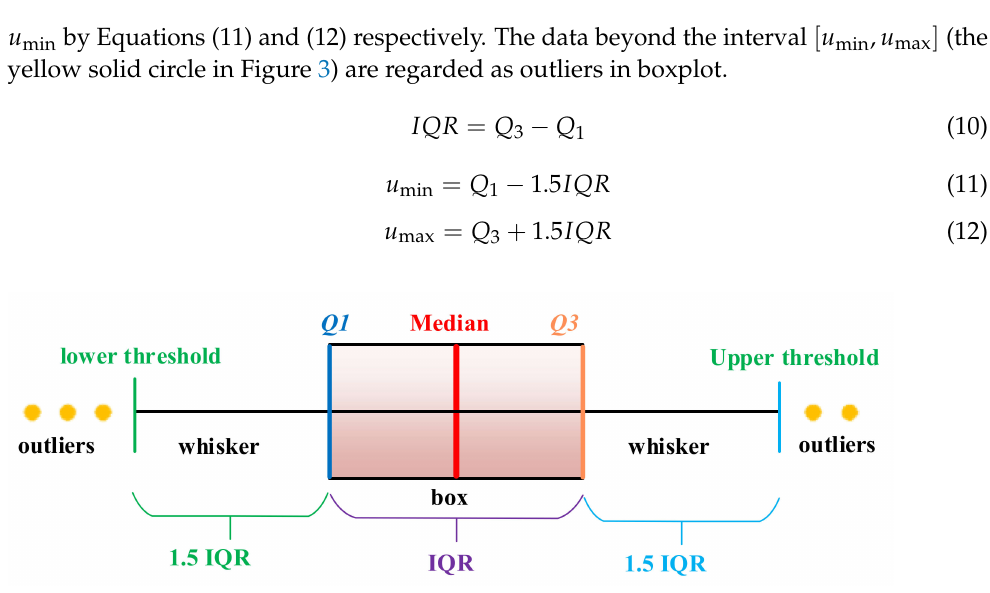
Figure 3. Principle of boxplot.